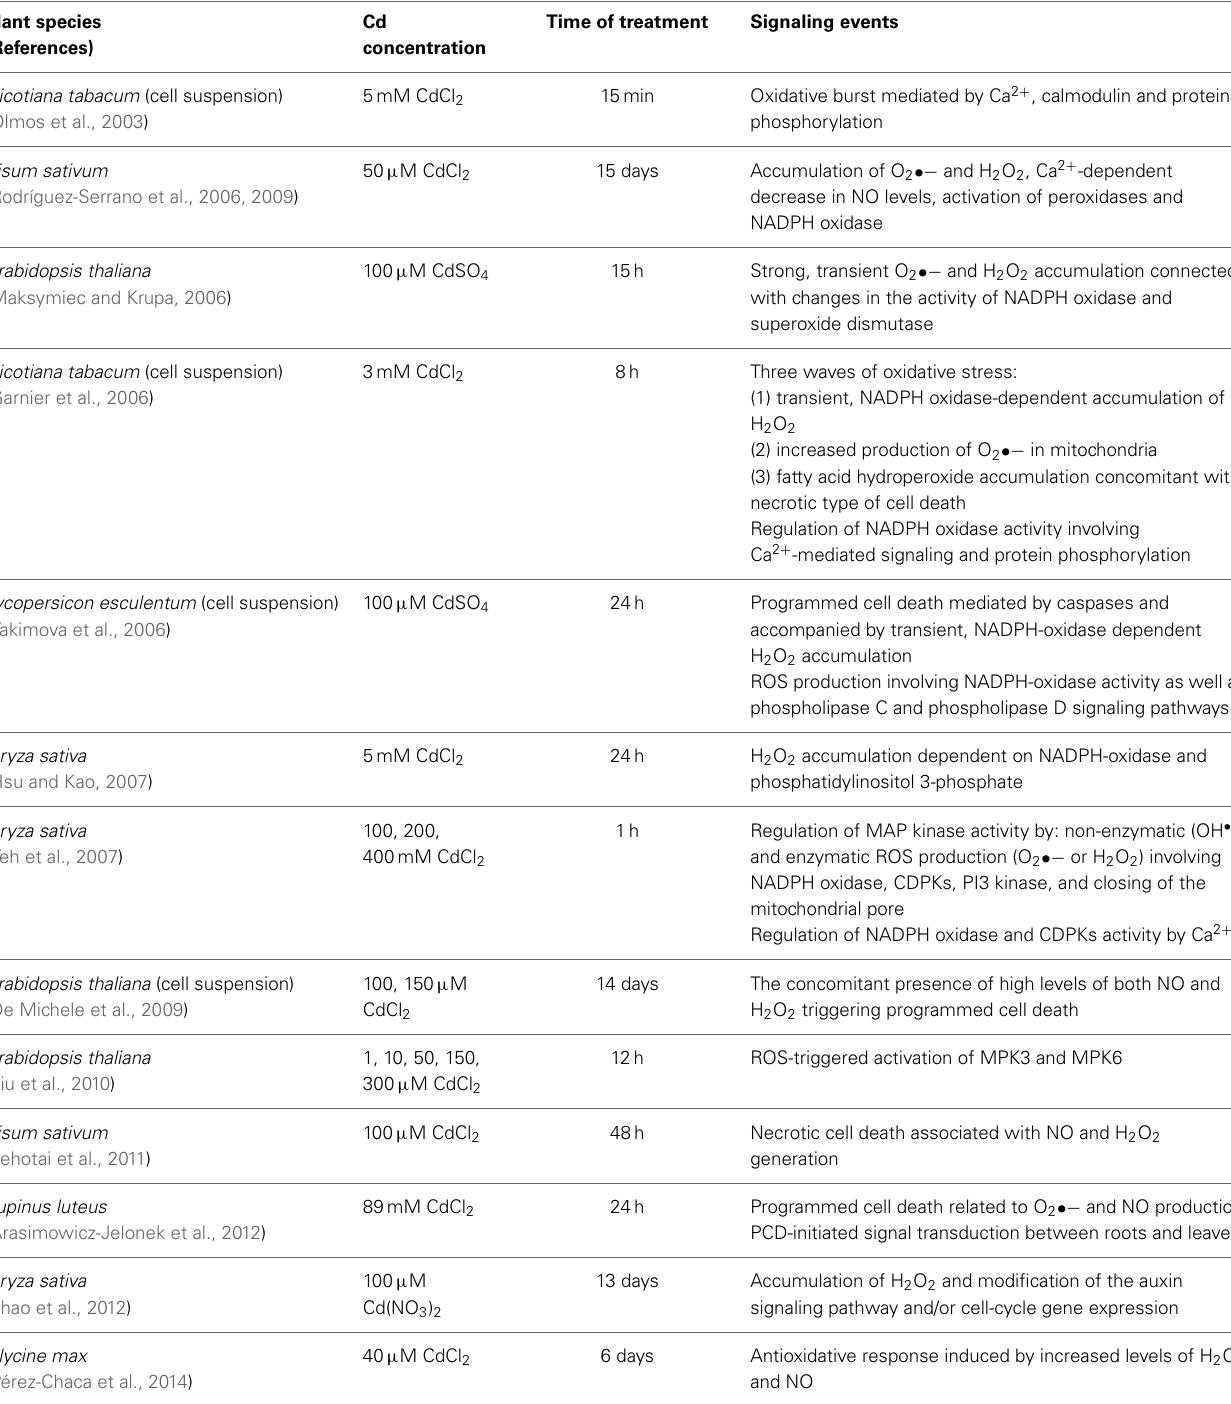
Table 1 | Summary of Cd-induced signaling events mediated by reactive oxygen species (ROS) in different plant species. Plant